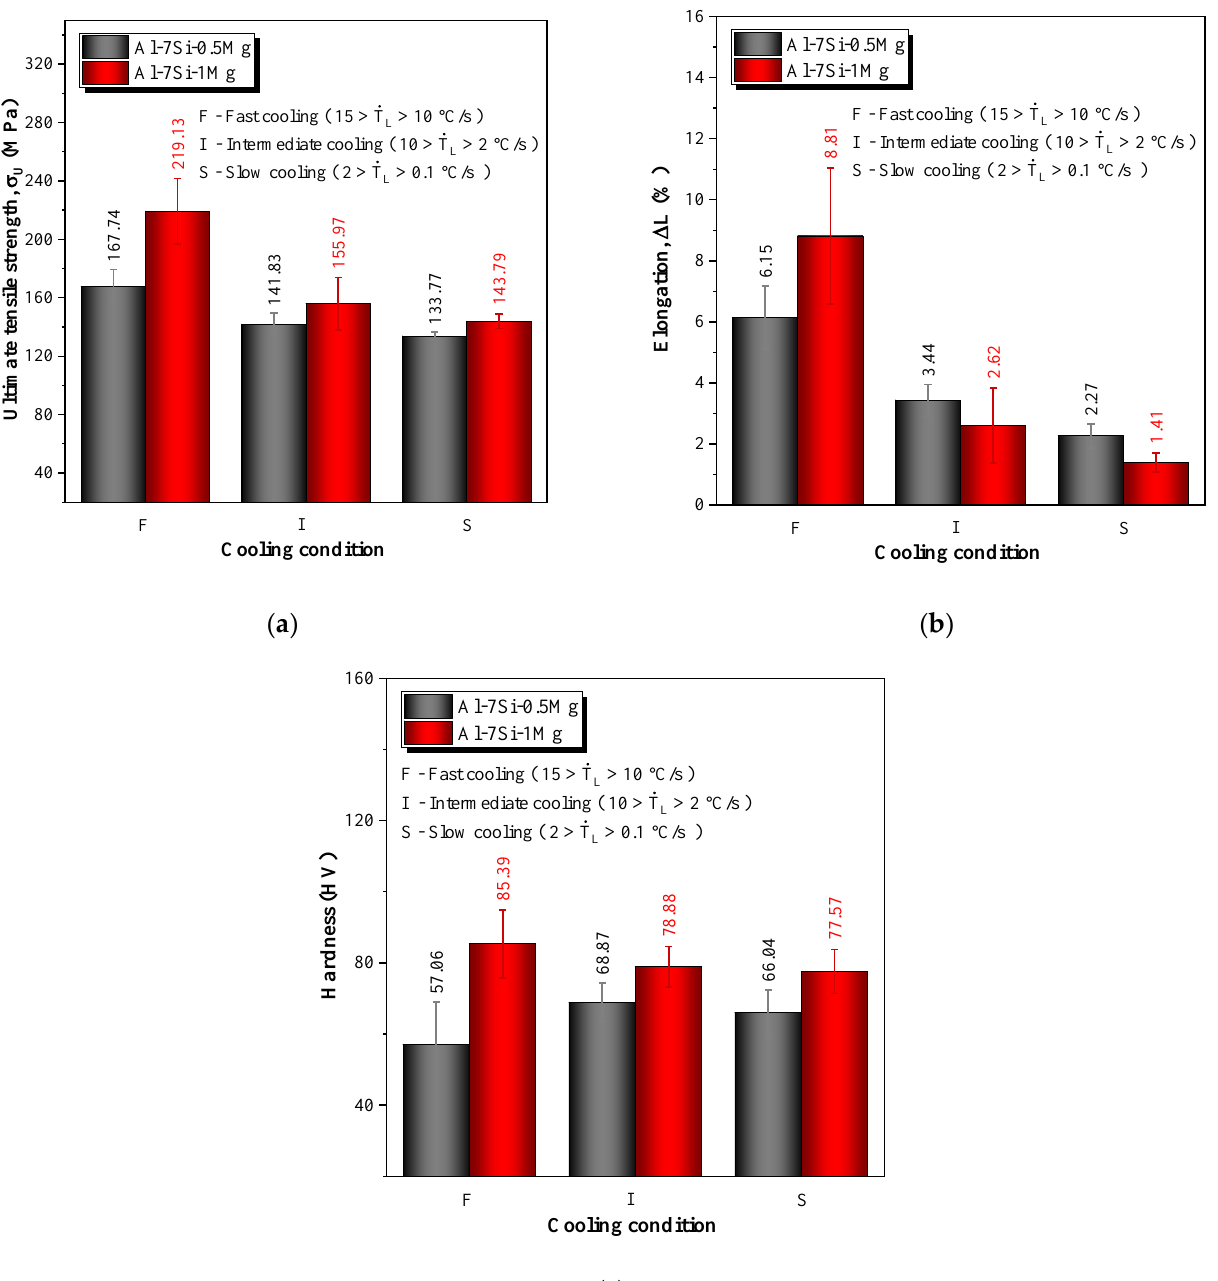
Figure 10. ( a ) Ultimate tensile strength, ( b ) elongation and ( c ) hardness of the Al-7Si-0.5Mg and Al-7Si-1Mg alloys considering three different cooling regimes.